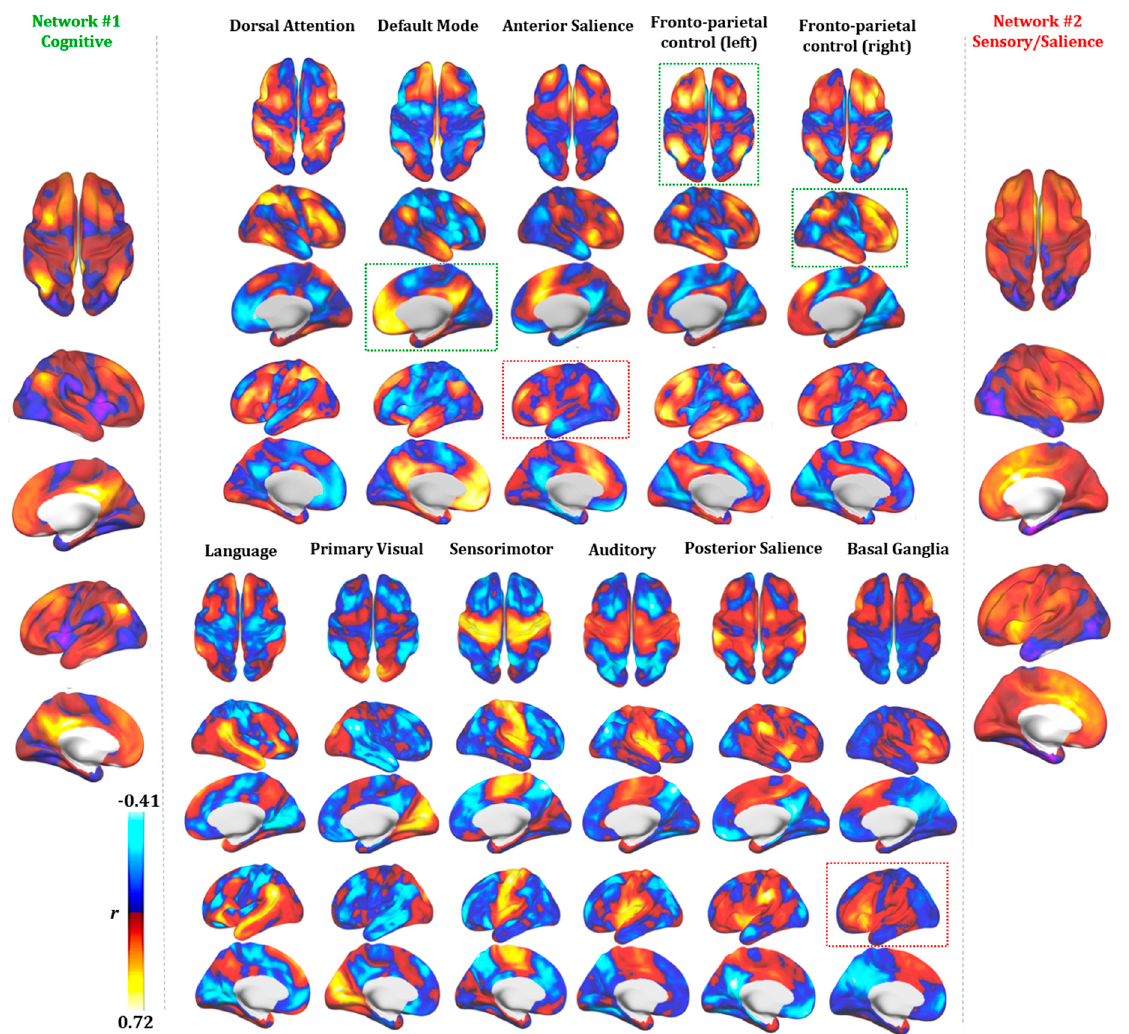
Figure 6. Functional connectivity profile of the two identified DoC networks. A visual comparison of seed-based connectivity maps for DoC networks (Network #1 and #2) and major Resting State Networks (RSNs) is shown. Red and blue colors represent the intensity and polarity of connectivity between each network and the rest of the brain. At the qualitative level, Network #1 (cognitive) resembles the fronto-parietal control network (right and left FPCN) and the Default Mode Network (DMN) is highlighted (green dotted lines). Qualitative similarity is also present for Network #2 (sensory / salience) and the anterior salience and basal ganglia networks (red dotted lines). Connectivity is expressed as the correlation coe ffi cient between the average Blood Oxygen Level-Dependent (BOLD) signal extracted from each map and that of any other voxel in the brain.